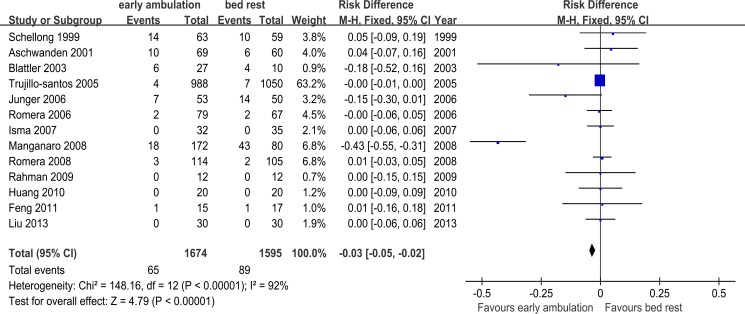
Meta-analysis of the incidence of primary end events among 1674 DVT patients with early ambulation and 1595 DVT patients with bed rest.